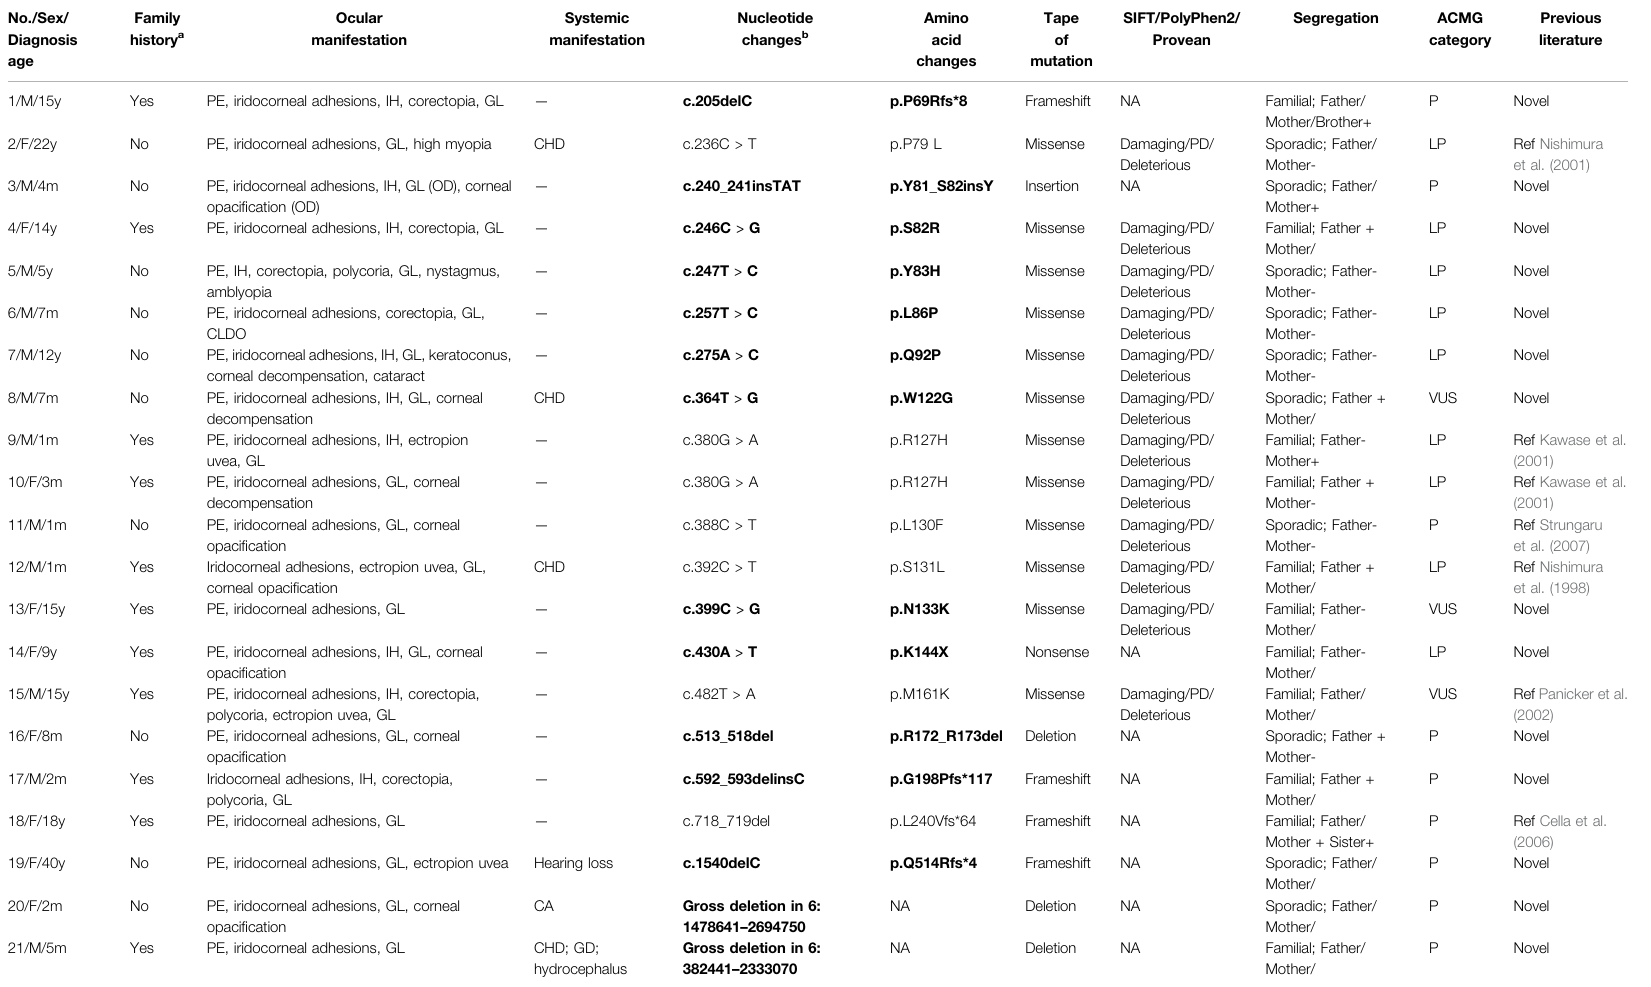
TABLE 1 | The genotype and phenotype of ARS patients with FOXC1 mutations or gross deletions of 6p25. No./Sex/ Diagnosis